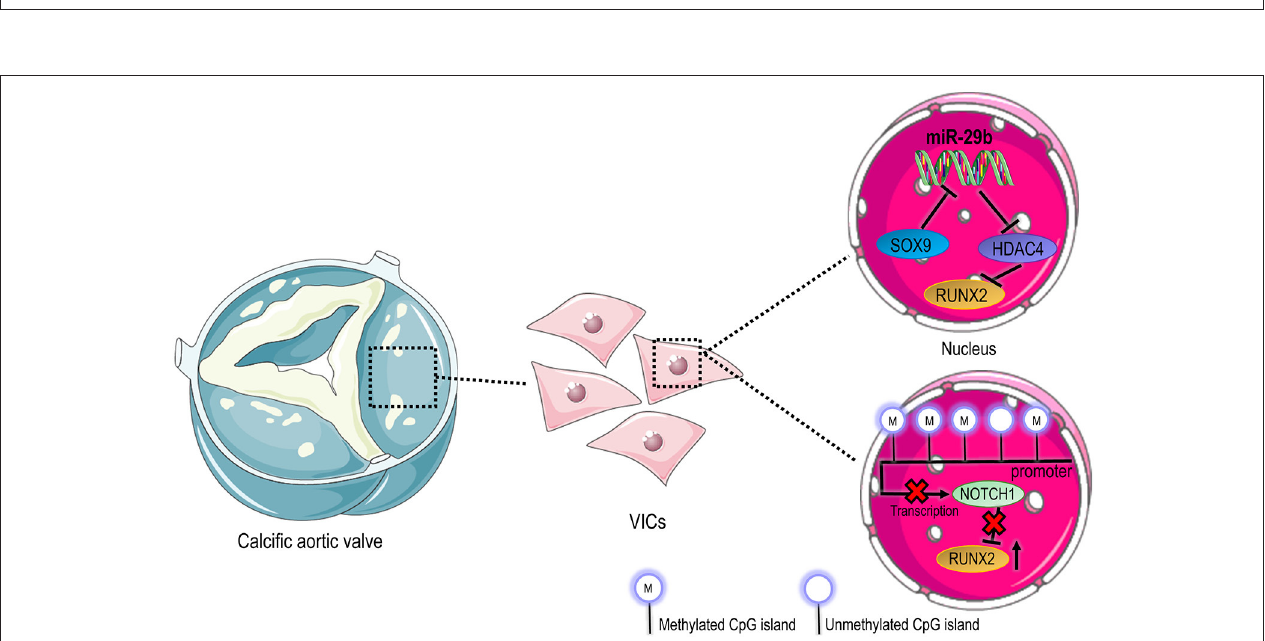
FIGURE 2 | Epigenetic regulation in CAVD. Compared to cells in native valves, where VICs have a prevalent quiescent phenotype, activated and osteoblastic VICs in pathologic valves undergo an extensive molecular reprogramming that involves different modalities of epigenetic control. In the top panel it is represented the transcriptional circuitry that controls the expression of Runx2 pro-osteogenic transcription factor through regulation of HDAC4. On the bottom of the panel, the downregulation of Notch1 due to methylation of promoter sequences leads to upregulation of Runx2 , favoring the osteoblastic differentiation of VICs.